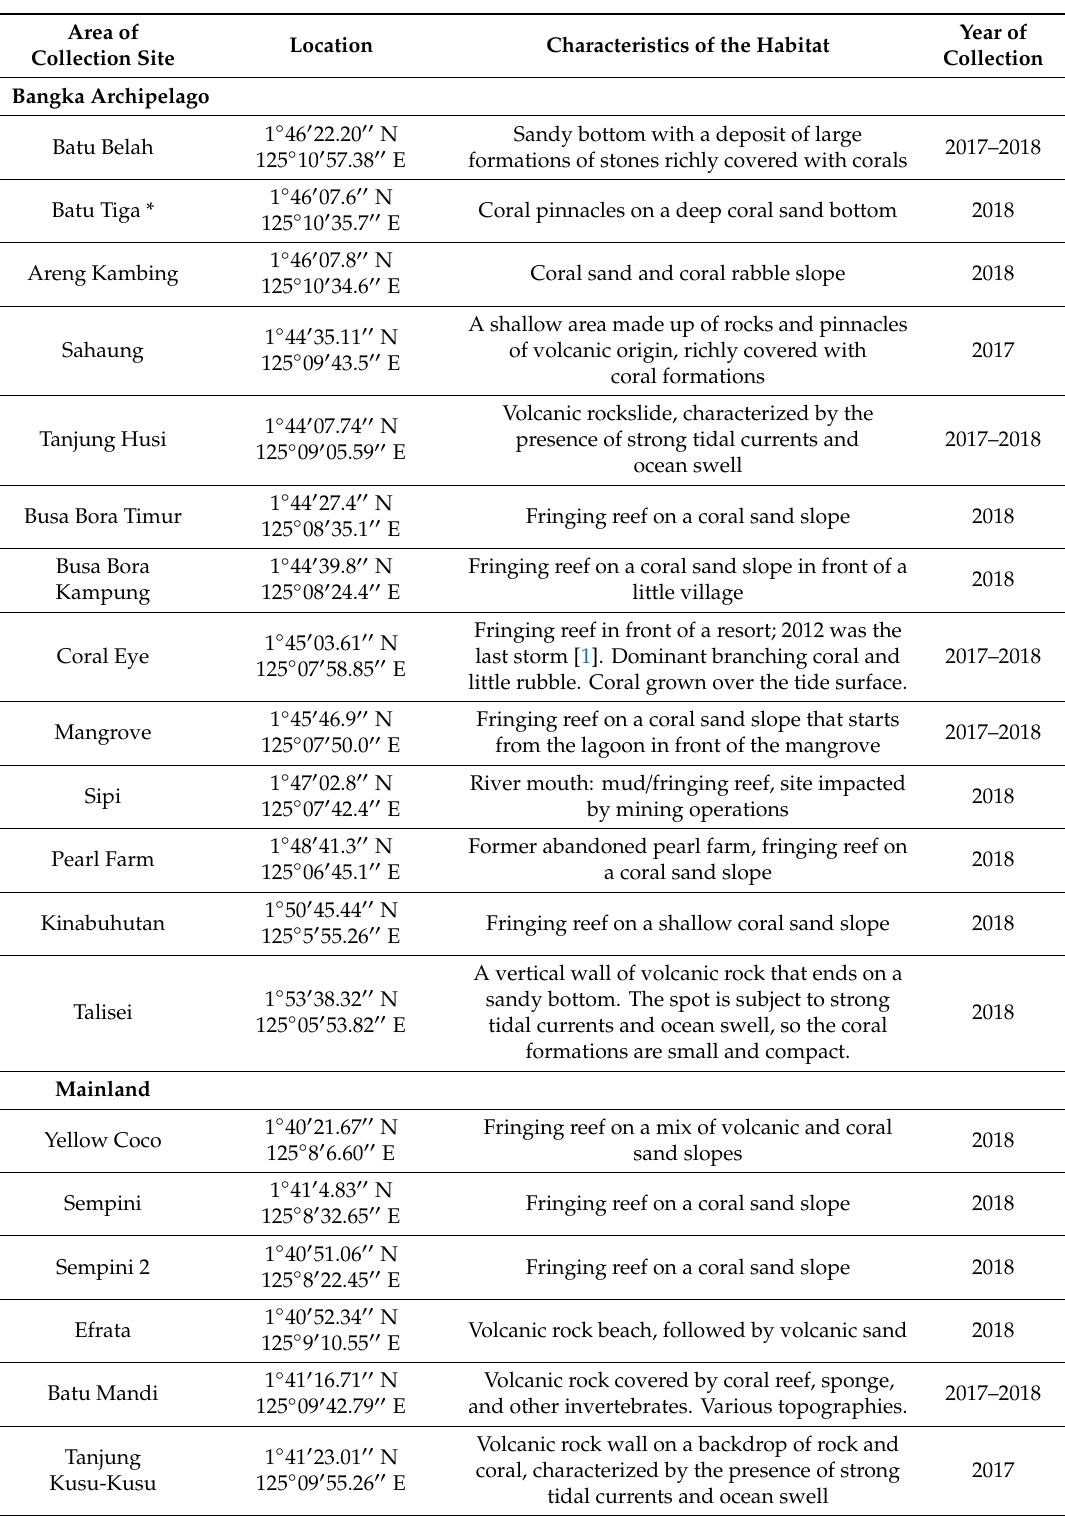
Table 1. Information about collection sites and dates in 2017–2018. * Batu Tiga is the only locality where no samples were collected, and specimens were recorded only by photo-documentation provided by Gianni